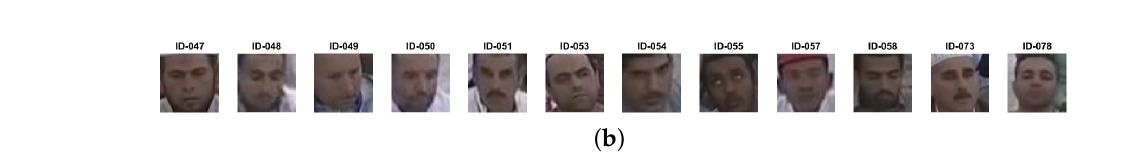
Figure 6. Recognized faces on sampled frame. ( a ) Predicted identification; ( b ) Actual identification.